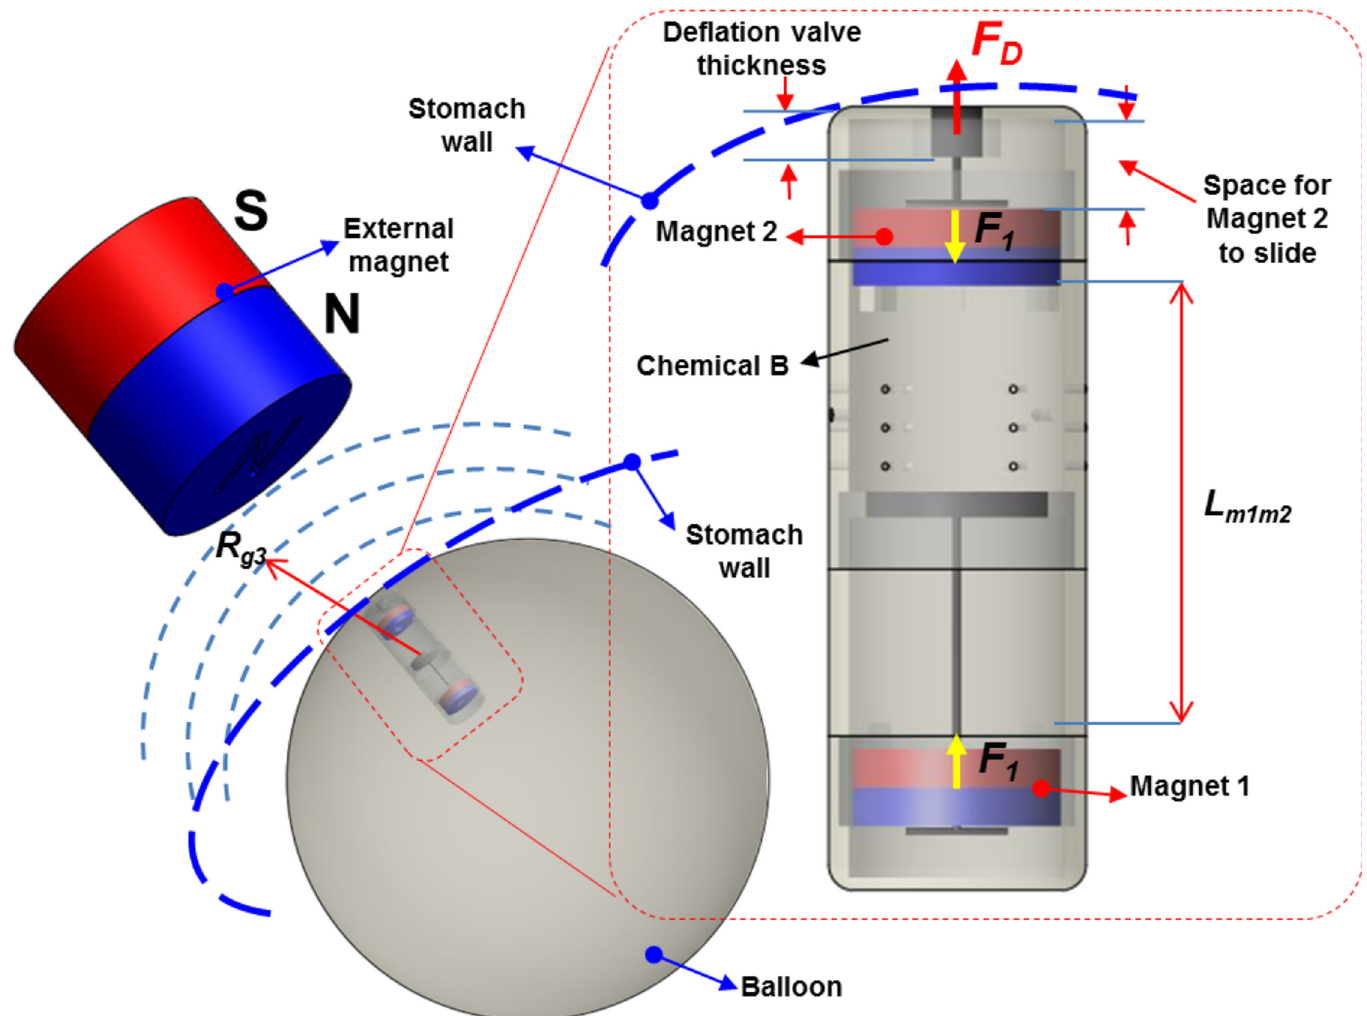
Fig 7. Operation principle for the deflation